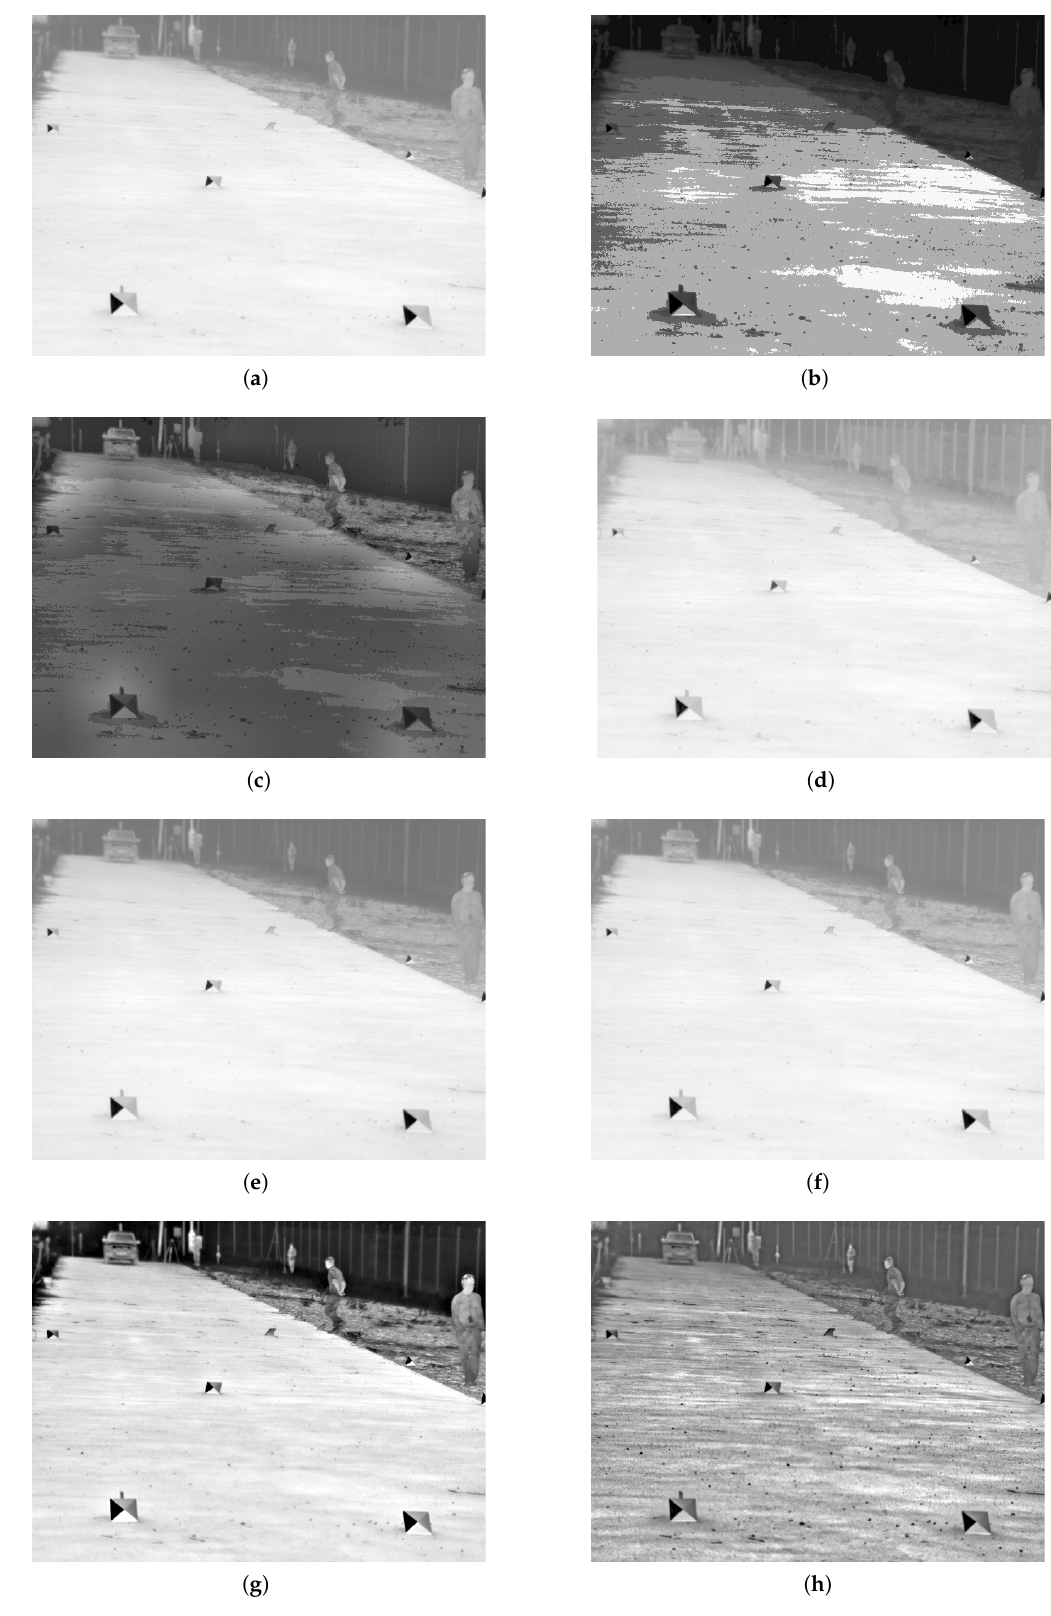
Figure 5. Comparison Results 2 (Low Contrast Image). ( a ) Linear Mapping. ( b ) HE. ( c ) CLAHE. ( d ) AHPBC. ( e ) MSR. ( f ) Reinhard. ( g ) LEP. ( h ) Proposed